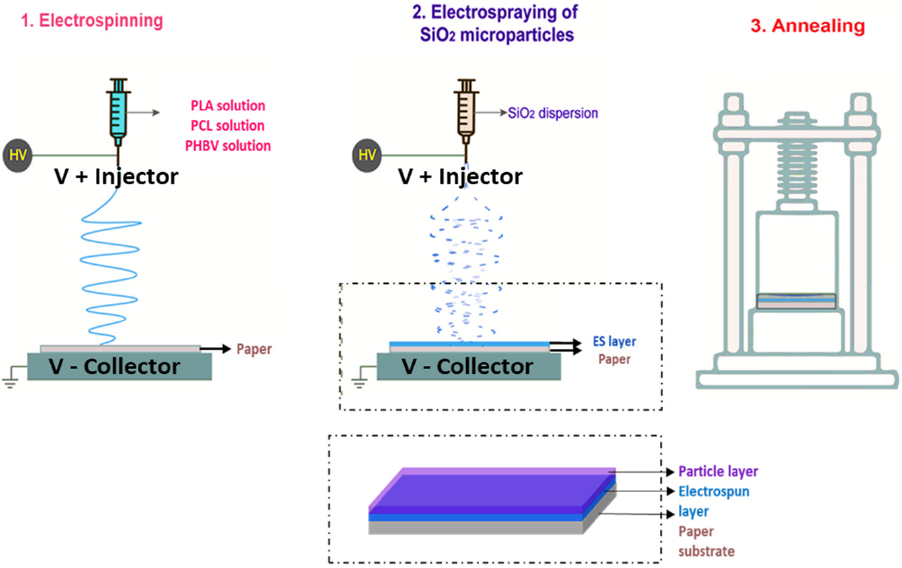
Figure 1. Schematic illustration of ( 1 ) deposition of the electrospun PLA, PCL, or PHBV fibers on cellulosic paper; ( 2 ) deposition of the electrosprayed silica (SiO 2 ) microparticles on the electrospun layer; and ( 3 ) thermal annealing of the paper substrate/electrospun layer/SiO 2 layer with a hot press without applying pressure.